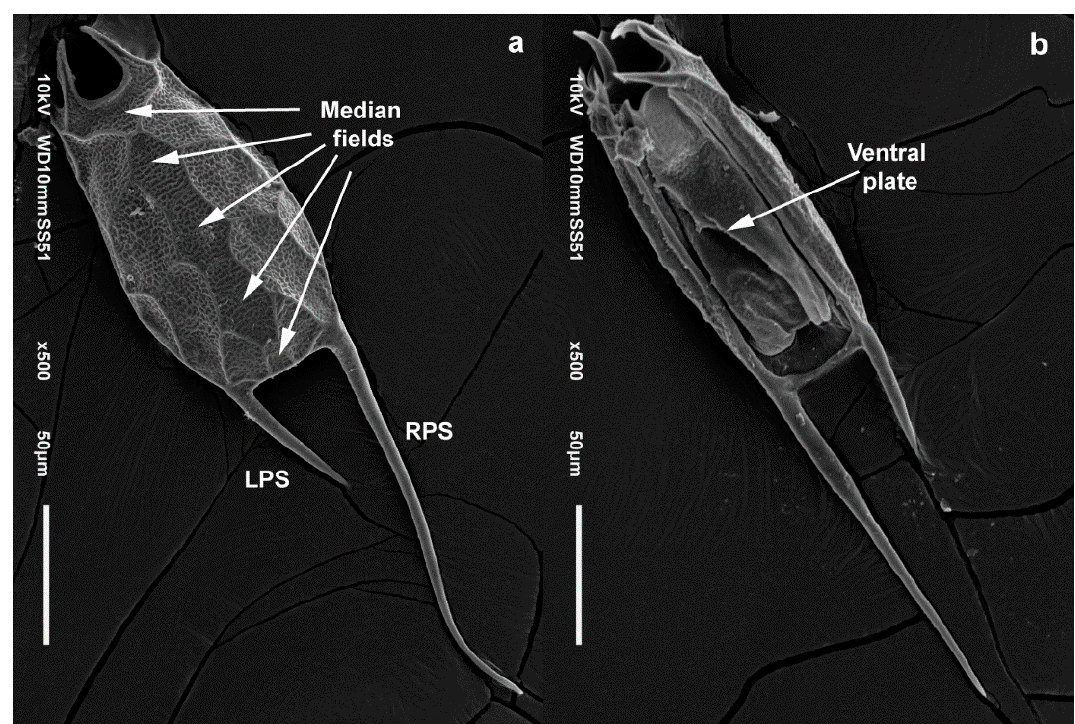
Figure 8. Morphology of Keratella cuitzeiensis sp. nov. ( a ). Dorsal view: arrows indicate the five median fields, RPS (Right Posterior Spine), LPS (Left Posterior Spine). ( b ). Ventral view. Females from Cuitzeo lagoon.